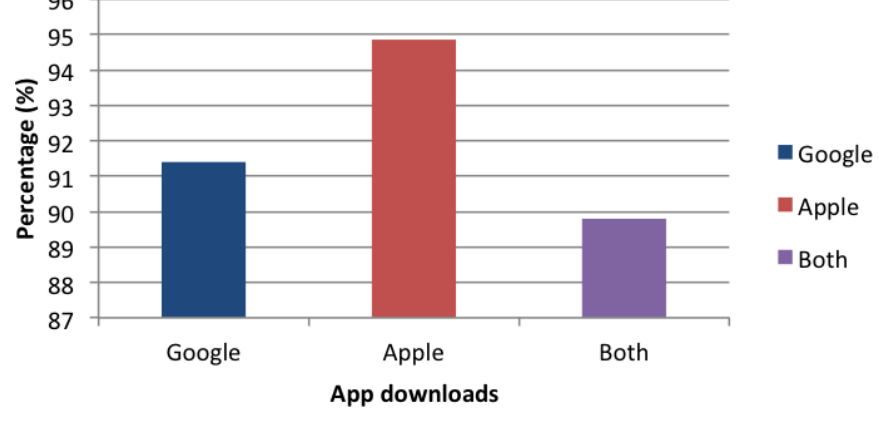
Figure 4. Chart comparing reminder function percentage among apps in different app